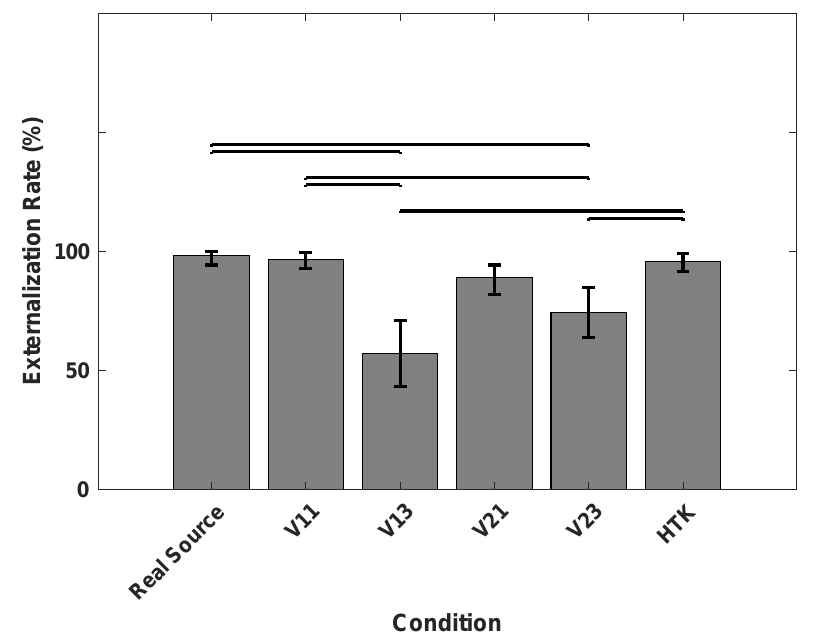
Figure 9. Externalization rate averaged over target positions, when listening to real sources in TestReal (Real Source) and to virtual sources in TestVR (generated with V11, V13, V21, V23 and HTK). Horizontal bars indicate significant differences (multiple comparison after Friedman test, p < 0.05). Error bars indicate 95% confidence